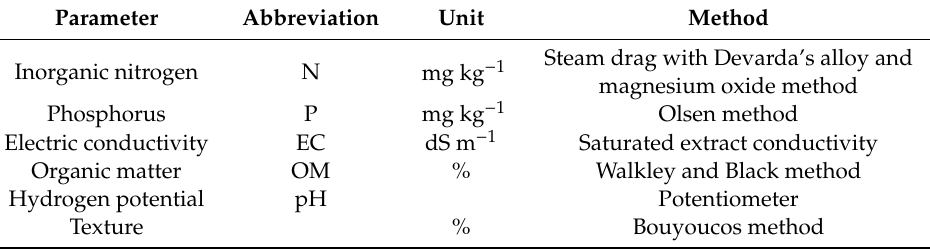
Table 2. Methods applied for the soil analysis, according to the Standard Mexican Norm (*). Parameter Abbreviation Unit Method Steam drag with Devarda’s alloy and Inorganic nitrogen N mg kg − 1 magnesium oxide method Phosphorus P mg kg − 1 Olsen method Electric conductivity EC dS m − 1 Saturated extract conductivity Organic matter OM % Walkley and Black method Hydrogen potential pH